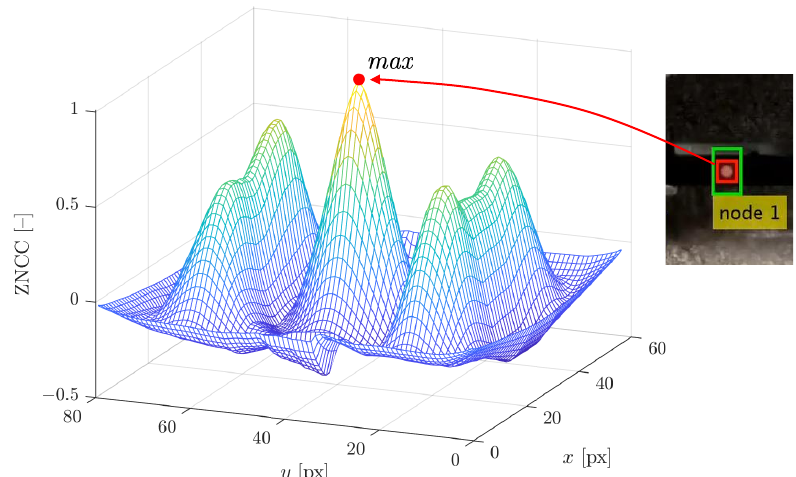
Figure 6. Example of the plot of the ZNCC function for Node